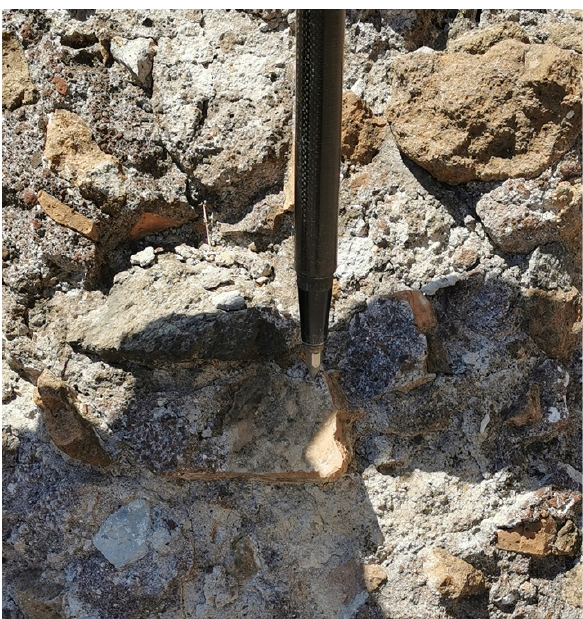
Figure 05 . Positioning of the total station near archaeological substructures. The presence of discontinuous elements has increased the level of difficulty in taking points.